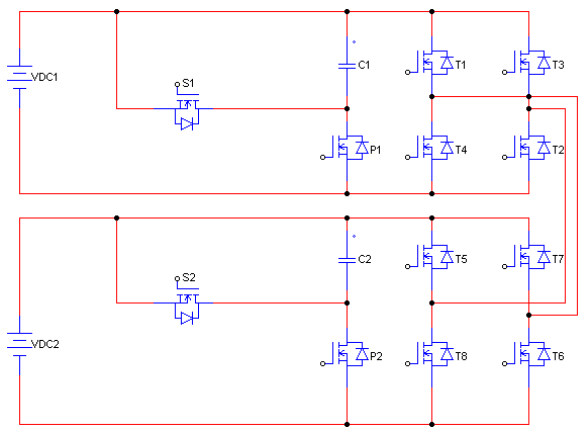
Figure 15. MLI based on switched capacitor.